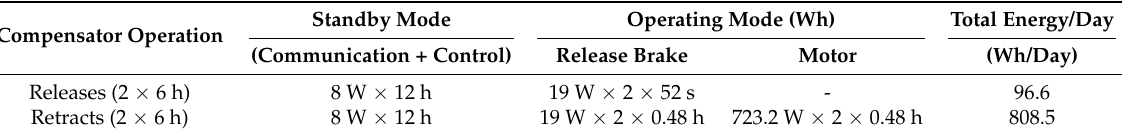
Table 1. Average energy required by the compensator over a 24 h period (every semi-diurnal cycle). Standby Compensator Operation